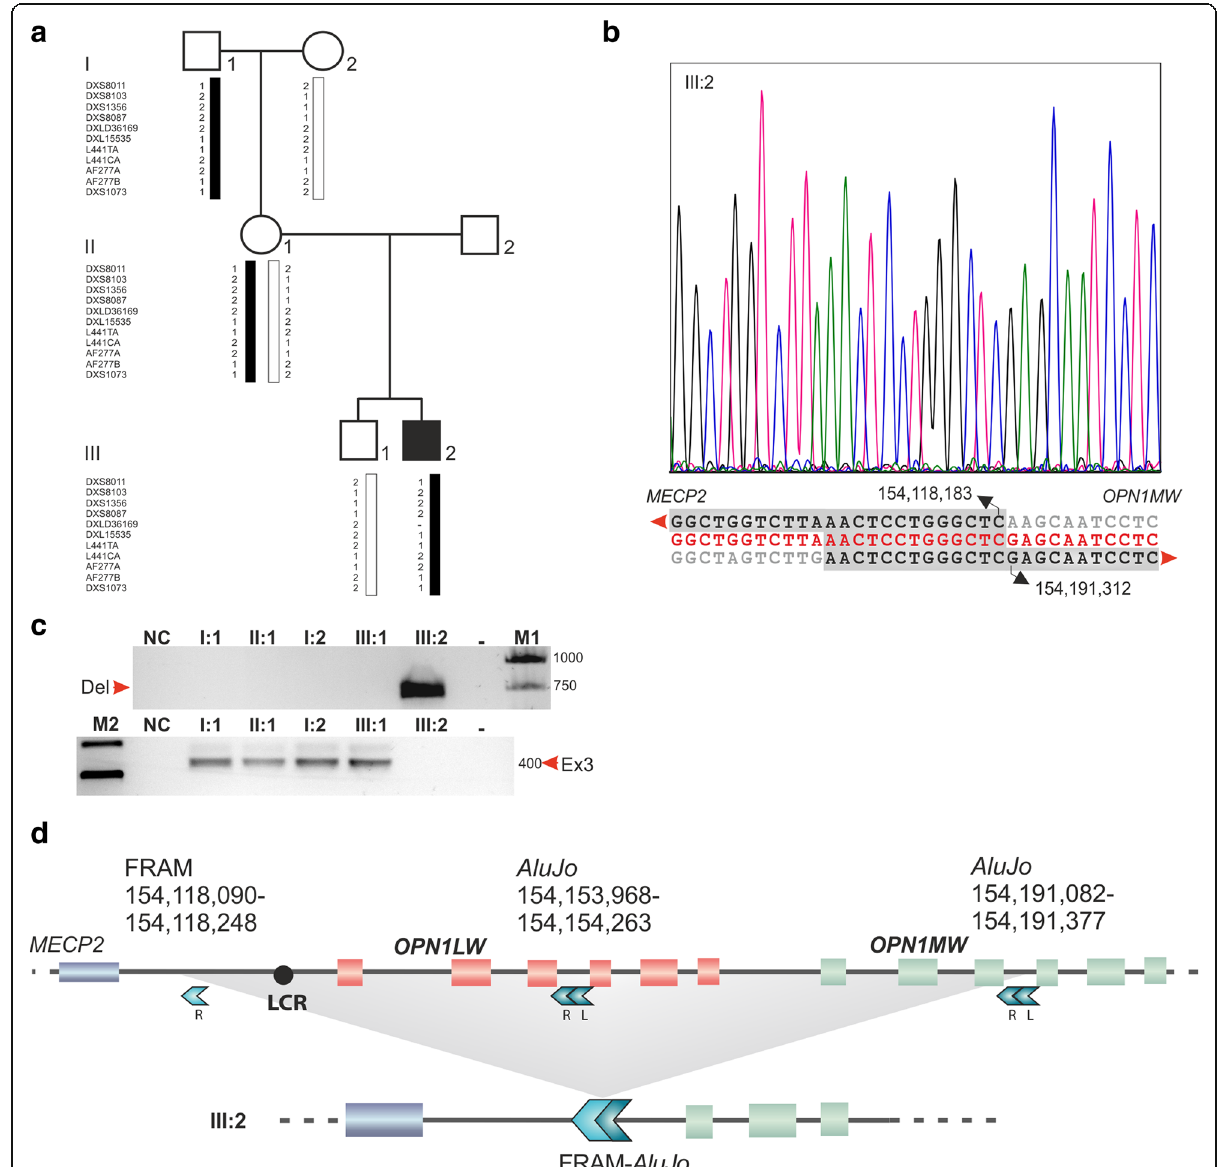
Fig. 2 Identification of a de novo 73,128 bp deletion at the cone opsin gene cluster a Pedigree of the family with a single affected male (III:2). Reconstructed haplotypes based on microsatellite markers flanking the OPN1LW/MW gene cluster within Xq28 revealed transmission of the X- chromosome from the maternal grandfather (I:1) to the index patient (III:2). b Sanger sequencing traces of the deletion breakpoints observed in the index patient (III:2) and its sequence depicted in red letters in the alignment underneath. Wildtype sequence at the centromeric and the telomeric breakpoint are depicted in black letters at the top and the bottom of the alignment, respectively. The breakpoints define a 73,128 bp deletion (NC_000023.11:g.154,118,184_154,191,311del) including the LCR, the entire OPN1LW gene and the first three exons of the OPN1MW gene. c Segregation analysis demonstrated the de novo occurence of the deletion. A breakpoint PCR amplicon yielded only a product for patient III:2 ( “ Del ” , upper agarose gel panel), whereas a PCR amplicon for exon 3 of OPN1LW and OPN1MW ( “ Ex3 ” , lower agarose gel panel) yielded products for the mother (II:1) and the grandfatehr (I:1) but not for the patient (III:2). M1 & M2: DNA size standards; NC: no DNA template negative control; − : empty well. d Schematic representation of the 73,128 bp deletion encompassing the LCR, the entire OPN1LW and 5 ′ parts of OPN1MW gene in the BCM patient (III:2). Red and green boxes depict individual exons of the OPN1LW and OPN1MW genes, respectively. The localization and composition of Alu elements most likely involved in the mutation event are shown as arrowheads. Physical coordinates refer to Genbank entry